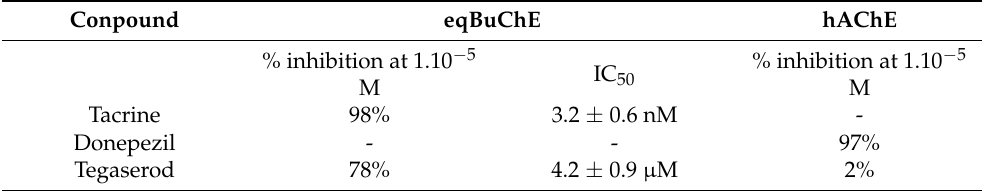
Table 2. Inhibitory activity of eqBuChE and hAChE (% inhibition or IC 50